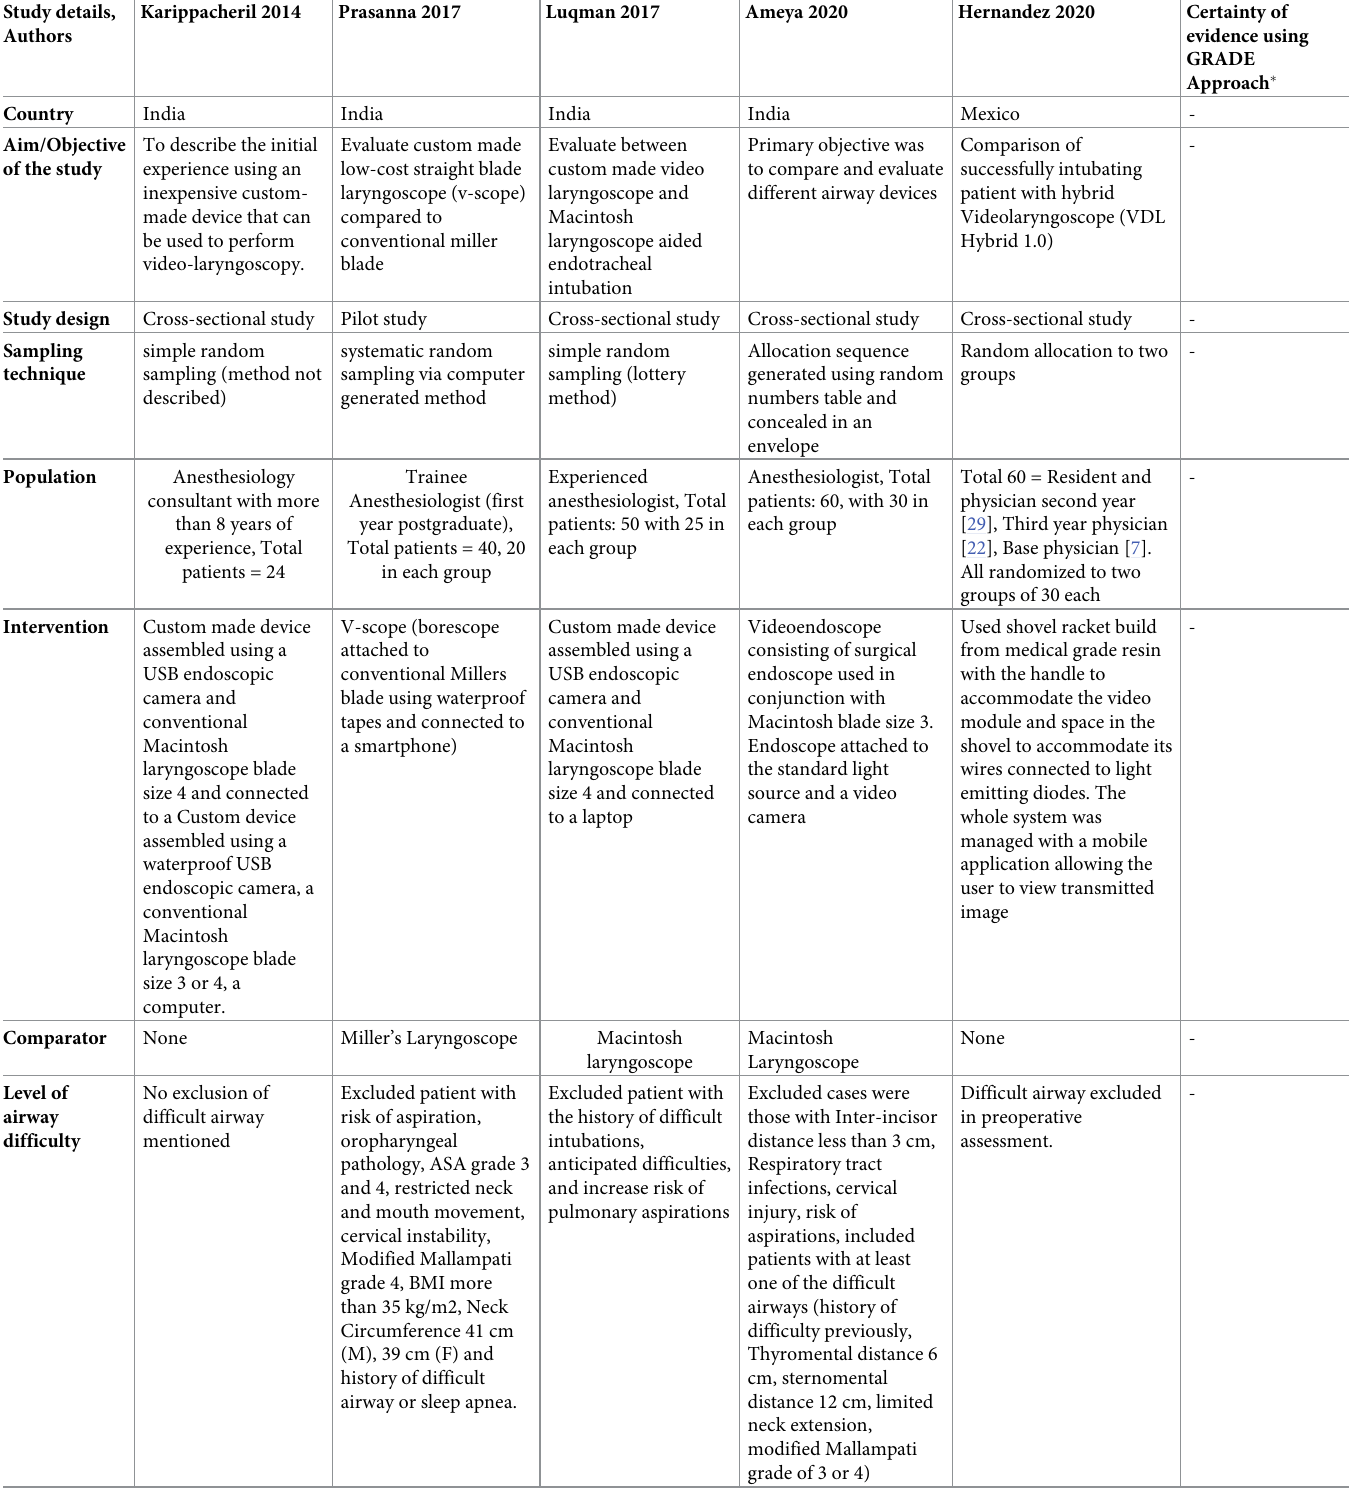
Table 1. Summary of the finding of all included